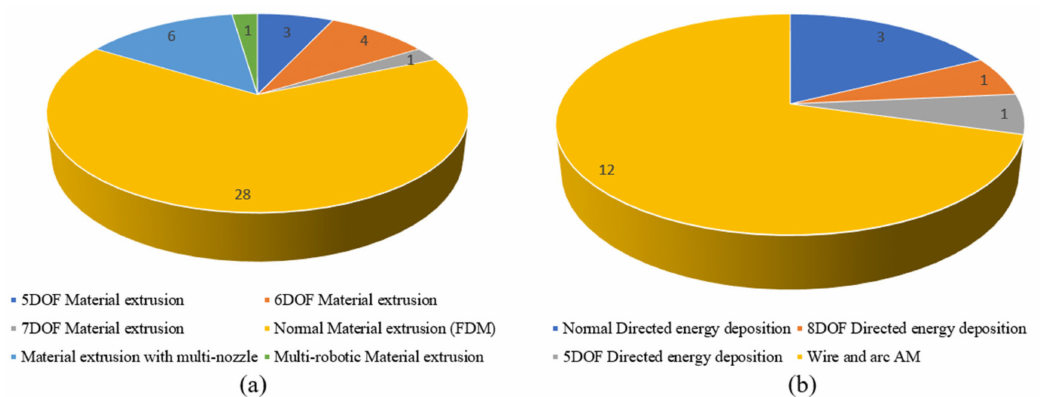
Figure 7. Number of publications on path planning in the seven AM categories.